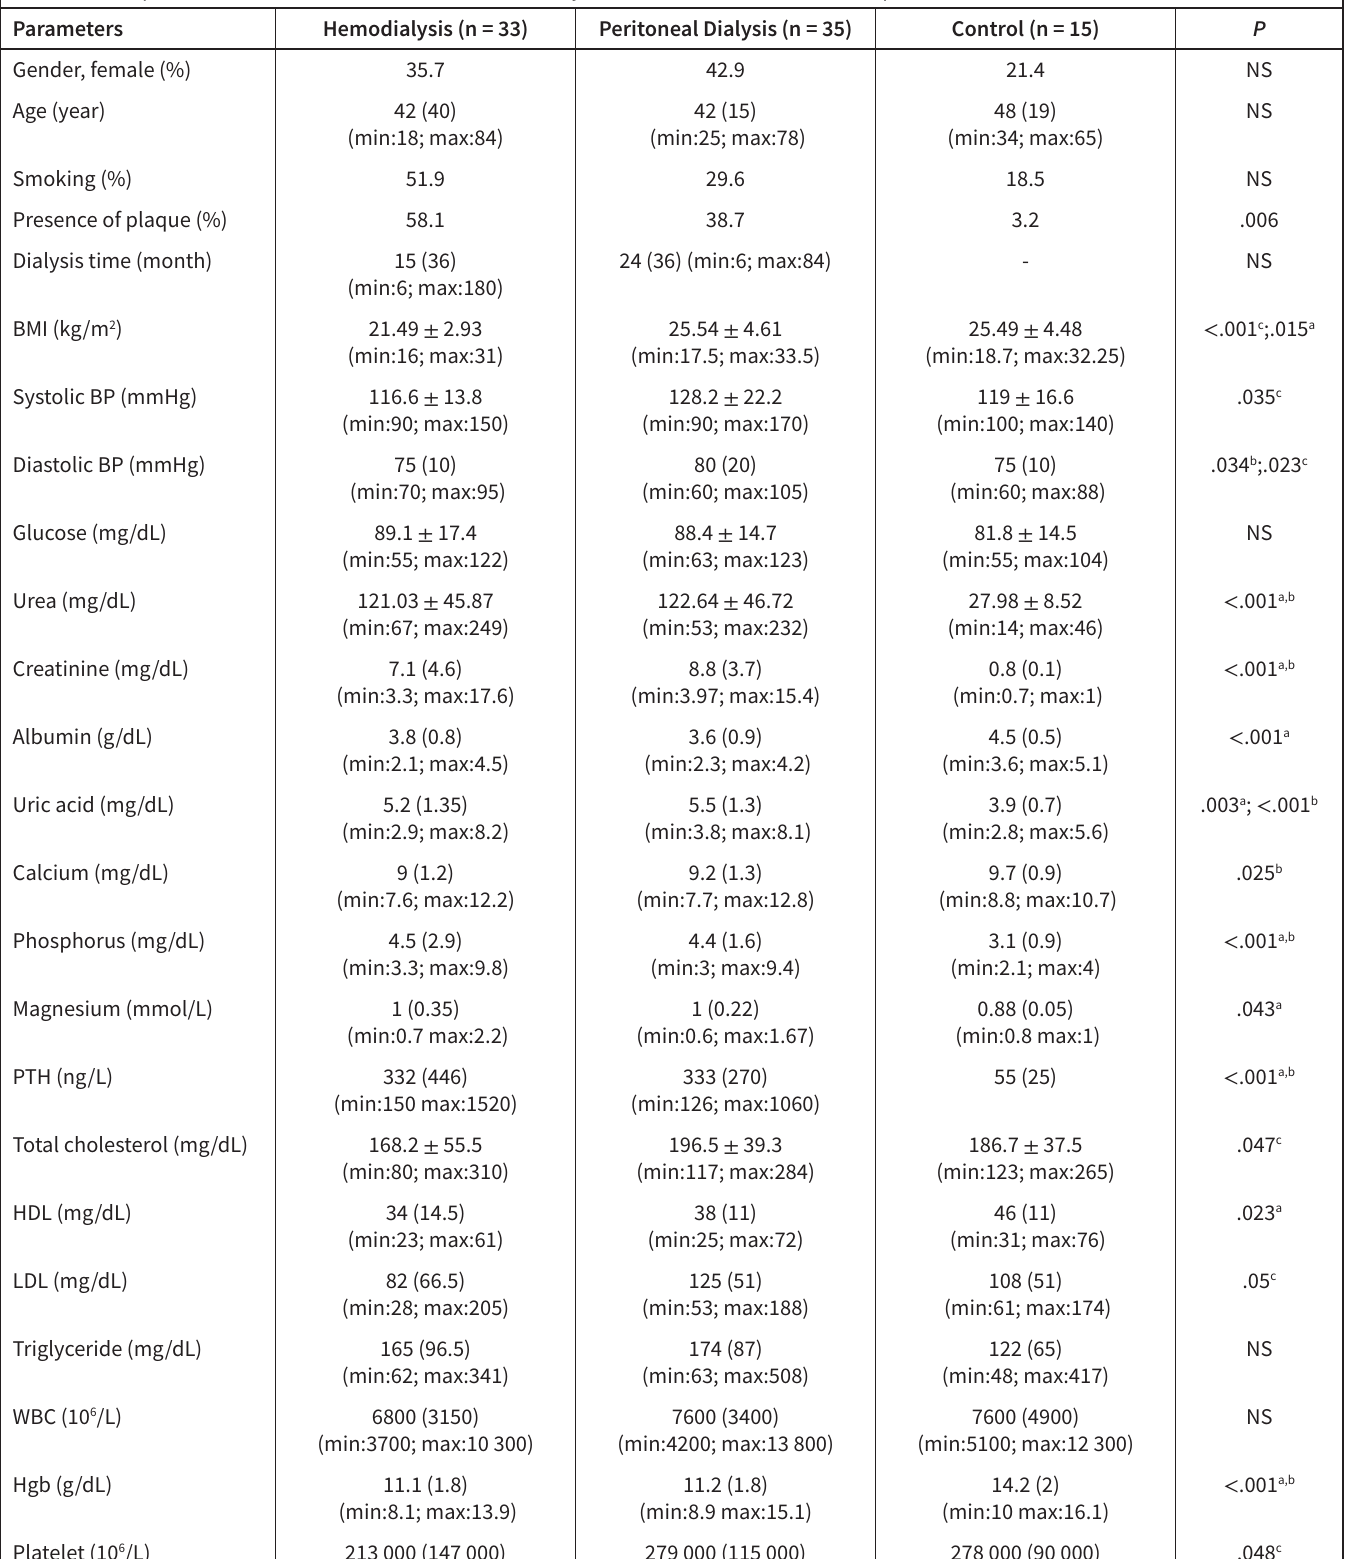
Table 1. Comparison of Basic Characteristics and Laboratory Parameters Between the 3 Groups